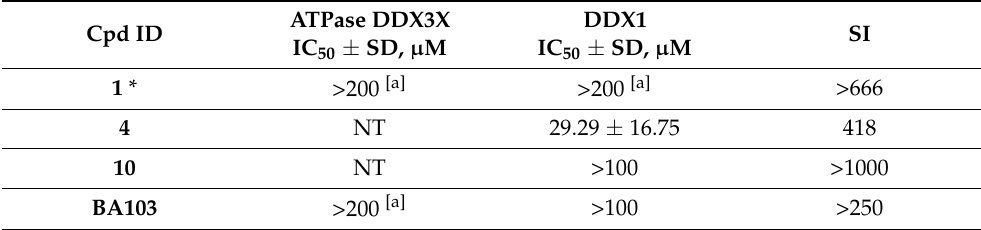
Table 2. Selectivity data on selected